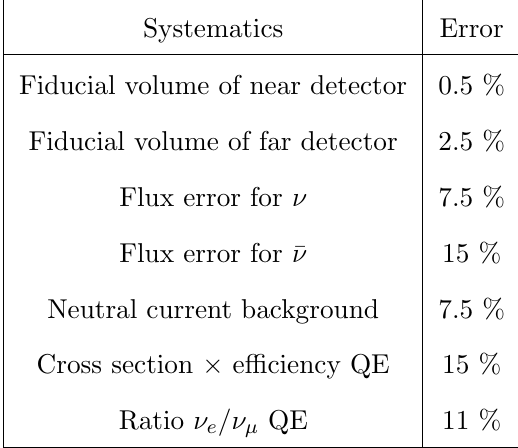
Table 10 . Considered values of the systematic errors. The abbreviation QE stands for \quasi-